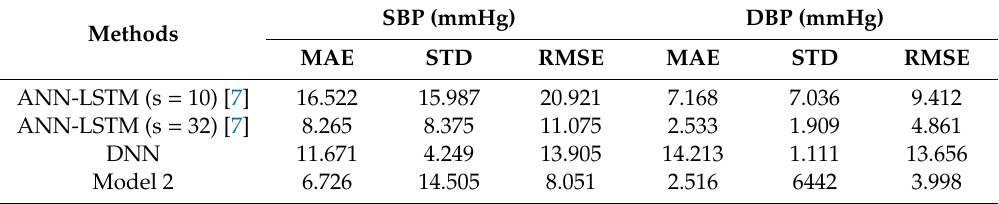
Table 5. Our proposed model compared with deep learning methods on 135,641